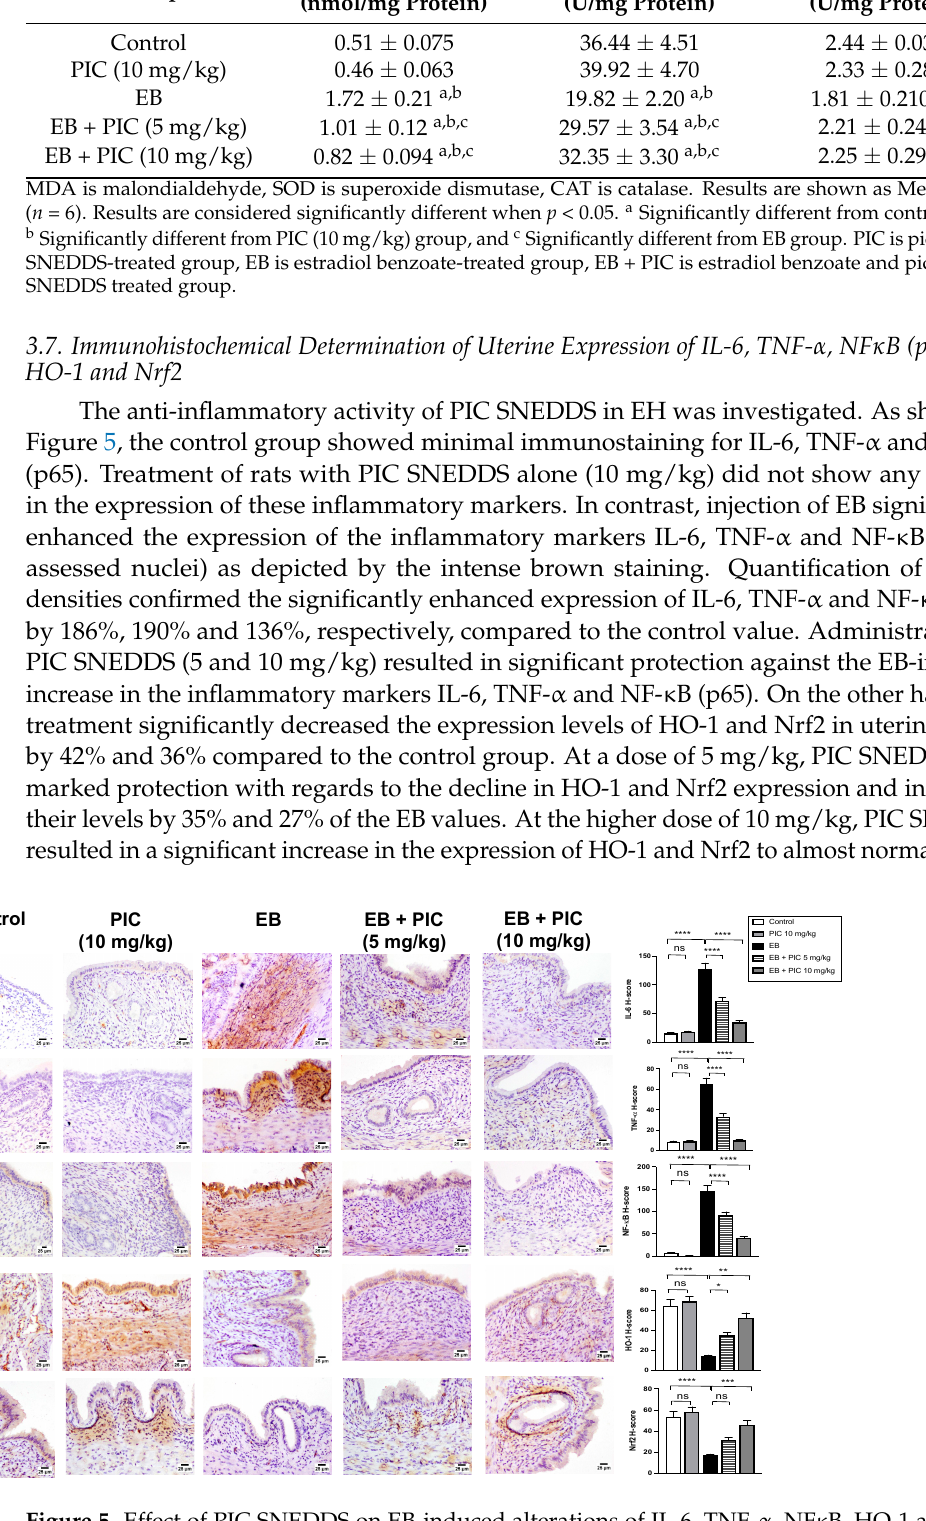
Figure 5. Effect of PIC SNEDDS on EB-induced alterations of IL-6, TNF- α , NF κ B, HO-1 and Nrf2 expression in the uterine tissue of rats by immunohistochemical staining. Data presented in bar graphs are the mean of H-scores ± S.D ( n = 6). ns = not significant, ** p <0.01, *** p <0.001 and **** p <0.0001.